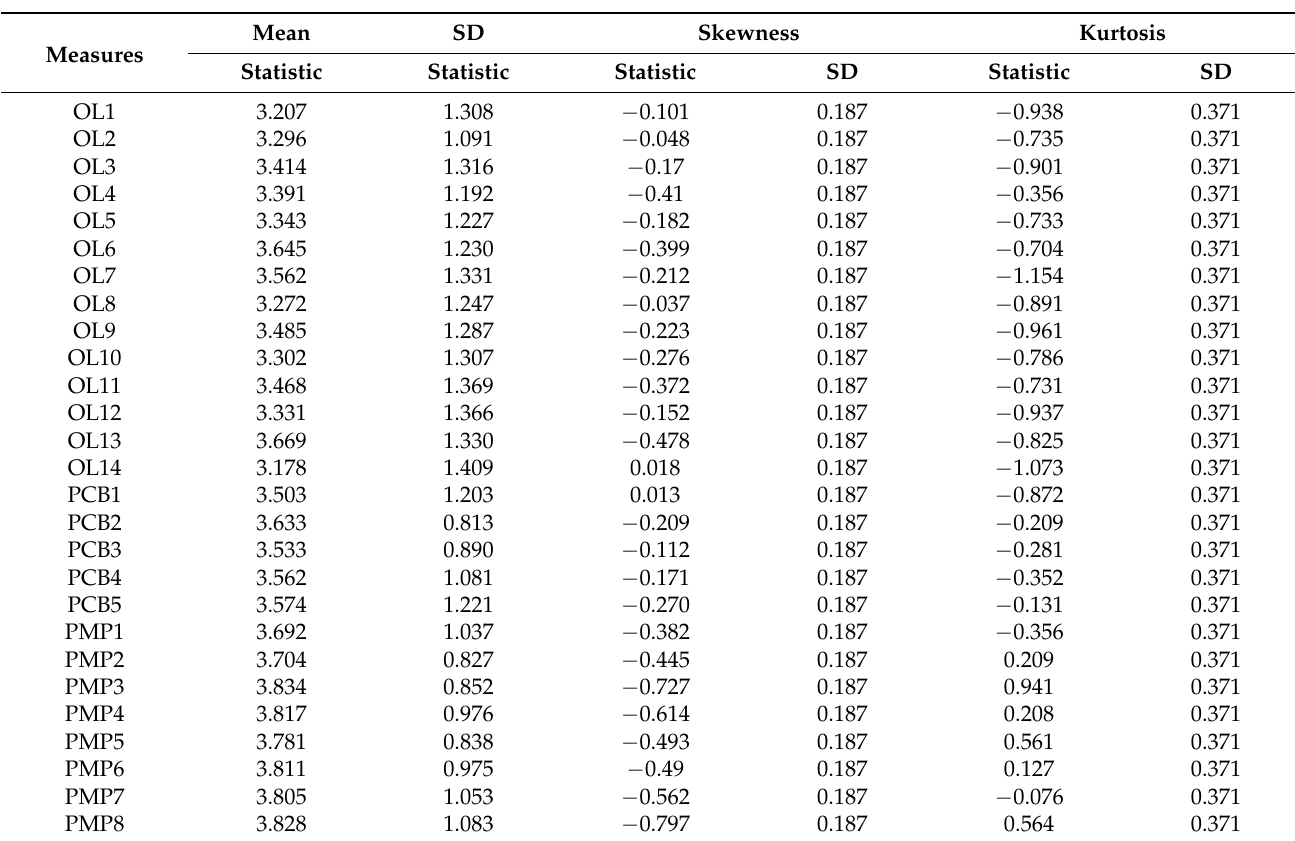
Table 3. Descriptive outline of the measures of OL, PCB, and